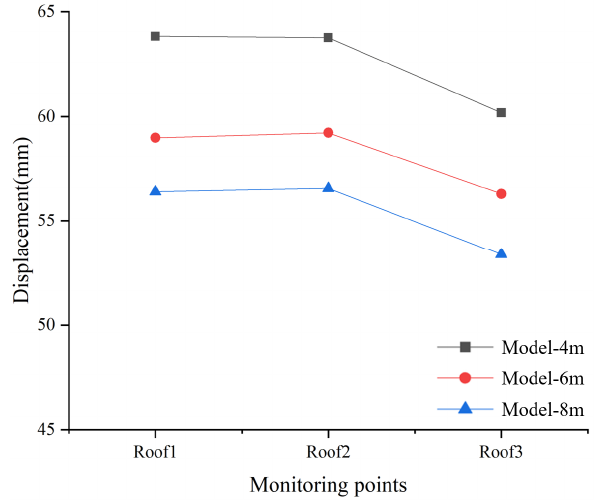
Figure 15. Vertical displacement distribution of the roof of the goaf-side entry with different yield